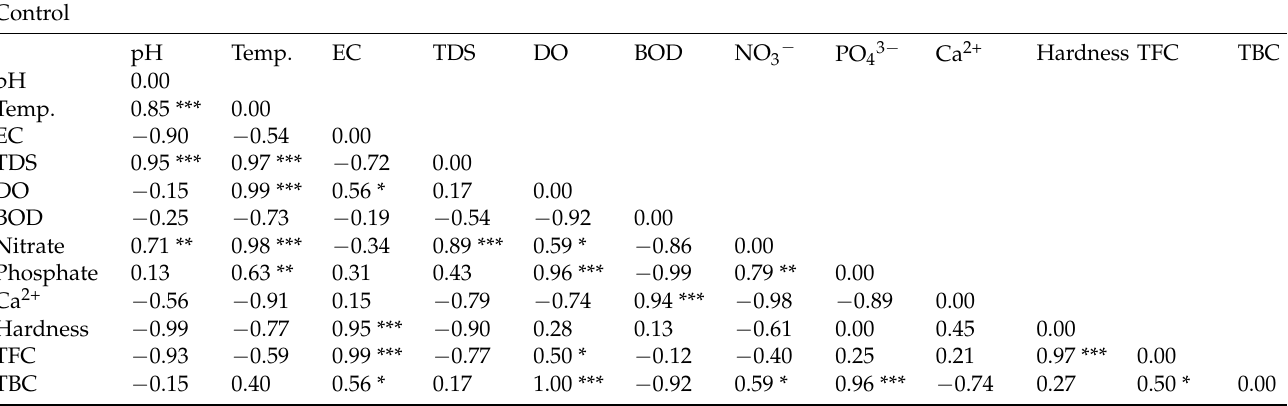
Table 2. Pearson correlation matrix showing the relationship between physicochemical parameters and microbial quality of the sachet water samples subjected to different storage